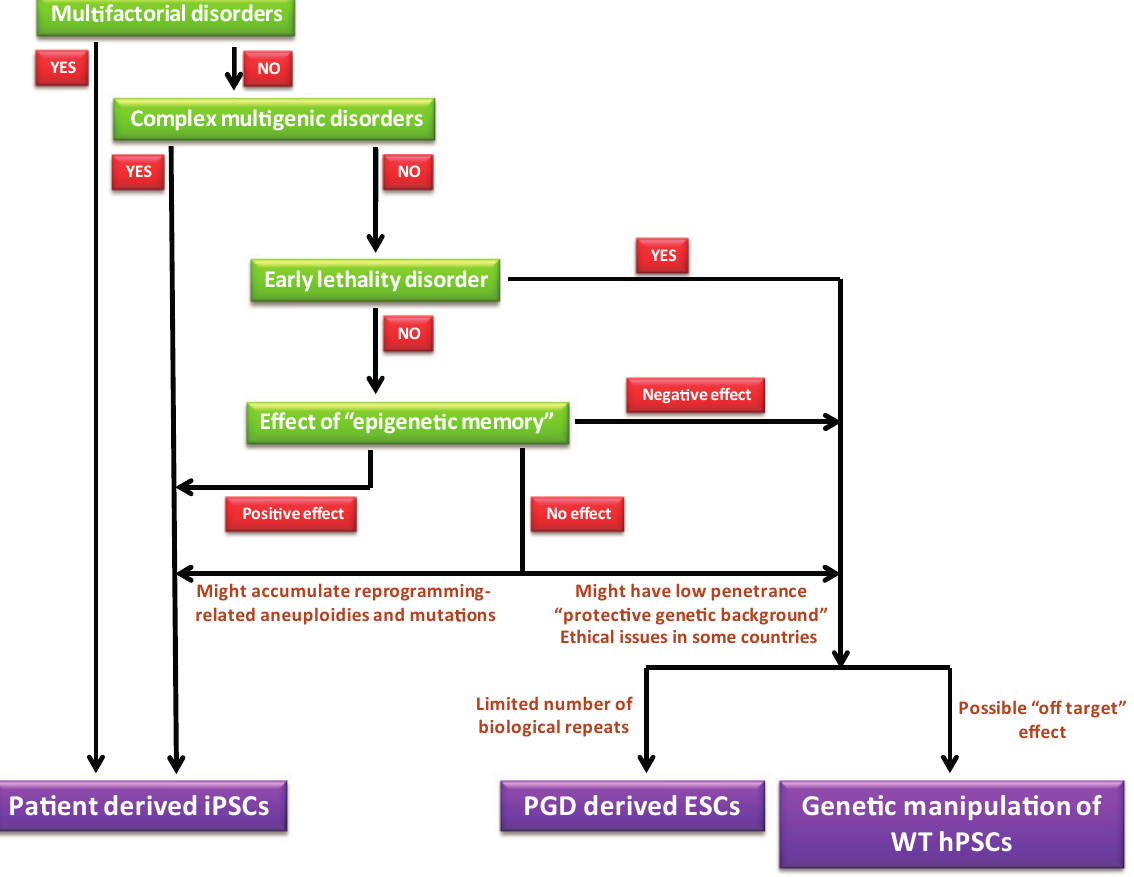
Figure 3. Scheme depicting the steps in choosing the appropriate system for disease modeling. While in some cases there is only one possible option (either ESCs or iPSCs), in other cases both ESCs or iPSCs can be used and the decision between the two methods should be done after the consideration of the advantageous and disadvantageous of each one of the options (some of them are described in the